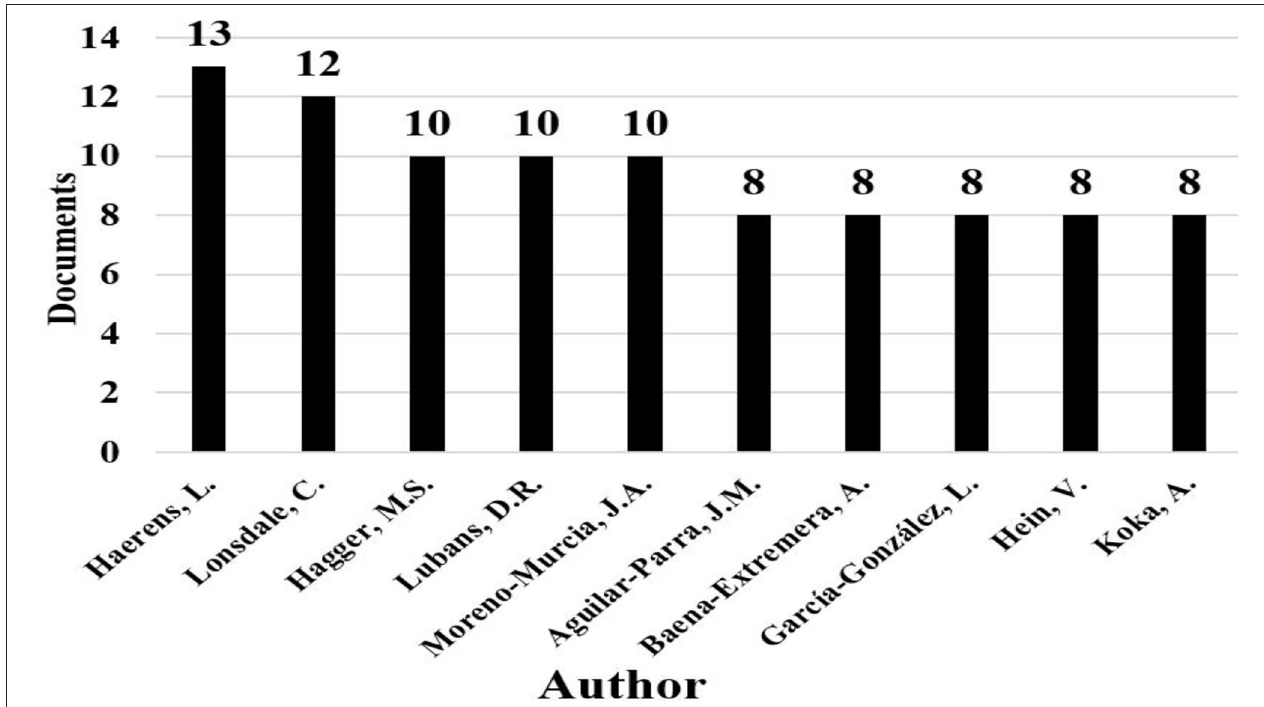
FIGURE 6 | Top 10